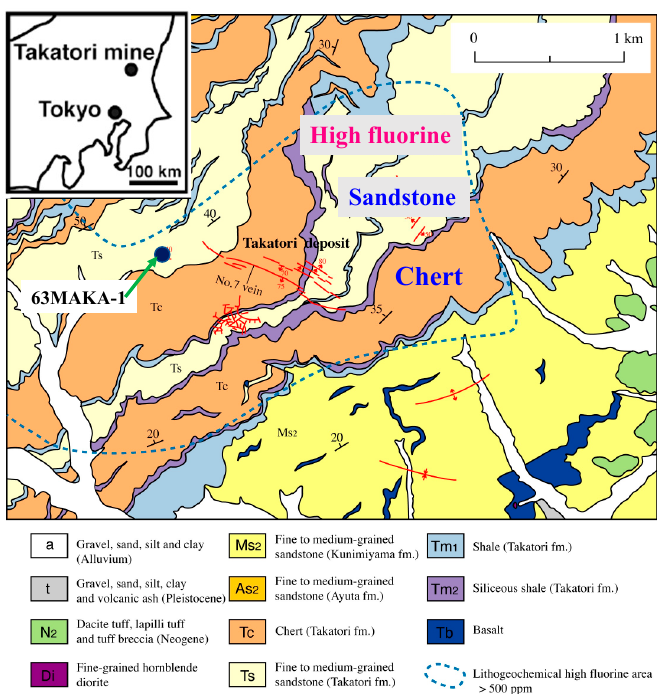
Figure 1. Geological map of the Takatori mining area, covered by the Jurassic Yamizo group accre- tionary sedimentary rocks comprising chert, sandstone, and shale (modified from [6]). The subsurface vein projection and structural attitudes (red lines) are shown. The location of drill hole 63MAKA-1 is shown. The high-fluorine area, with rocks containing more than 500 ppm of fluorine, is delineated by the dotted blue line.